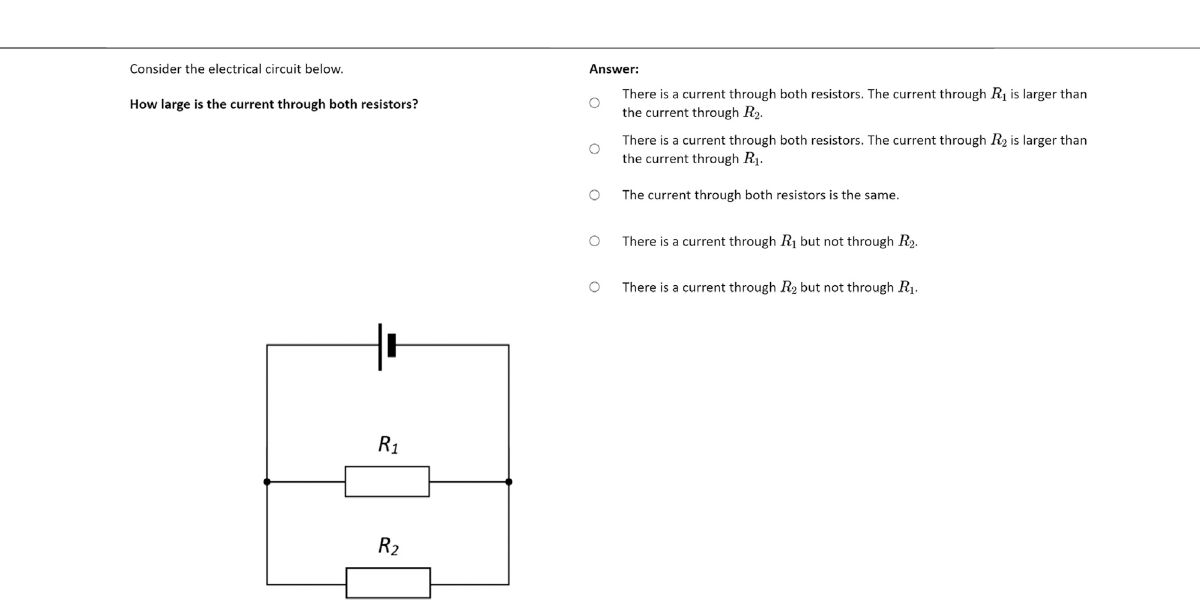
Frontiers in Education |